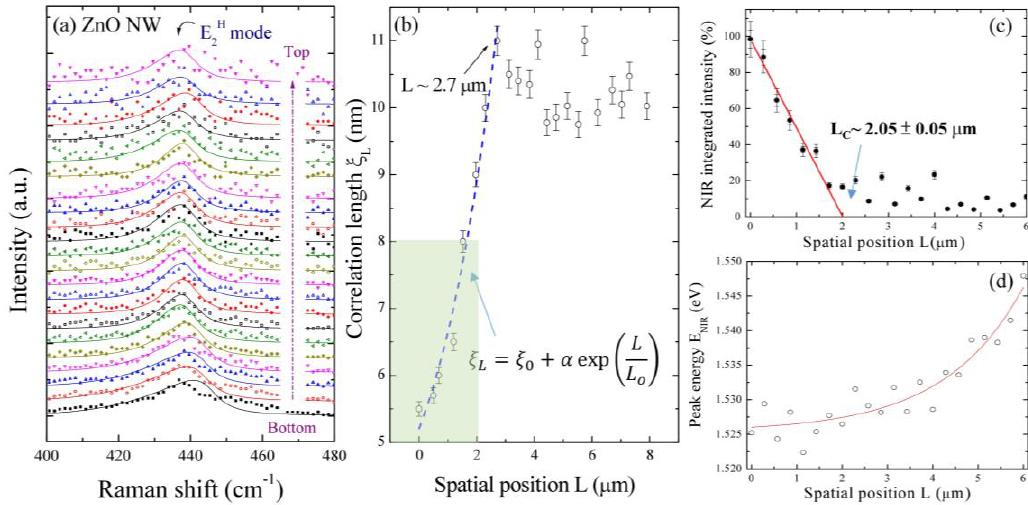
Figure 6. ( a ) A series of Raman spectra of the E 2H mode taken along the growth direction; ( b ) Correlation lengths versus the spatial position along the ZnO NW. Spatial position dependencies of ( c ) integrated intensity of NIR emission and ( d ) NIR sub-band gap energy. The solid red lines represent a linear fit to the intensity data and an exponential fit to the emission energy, respectively.